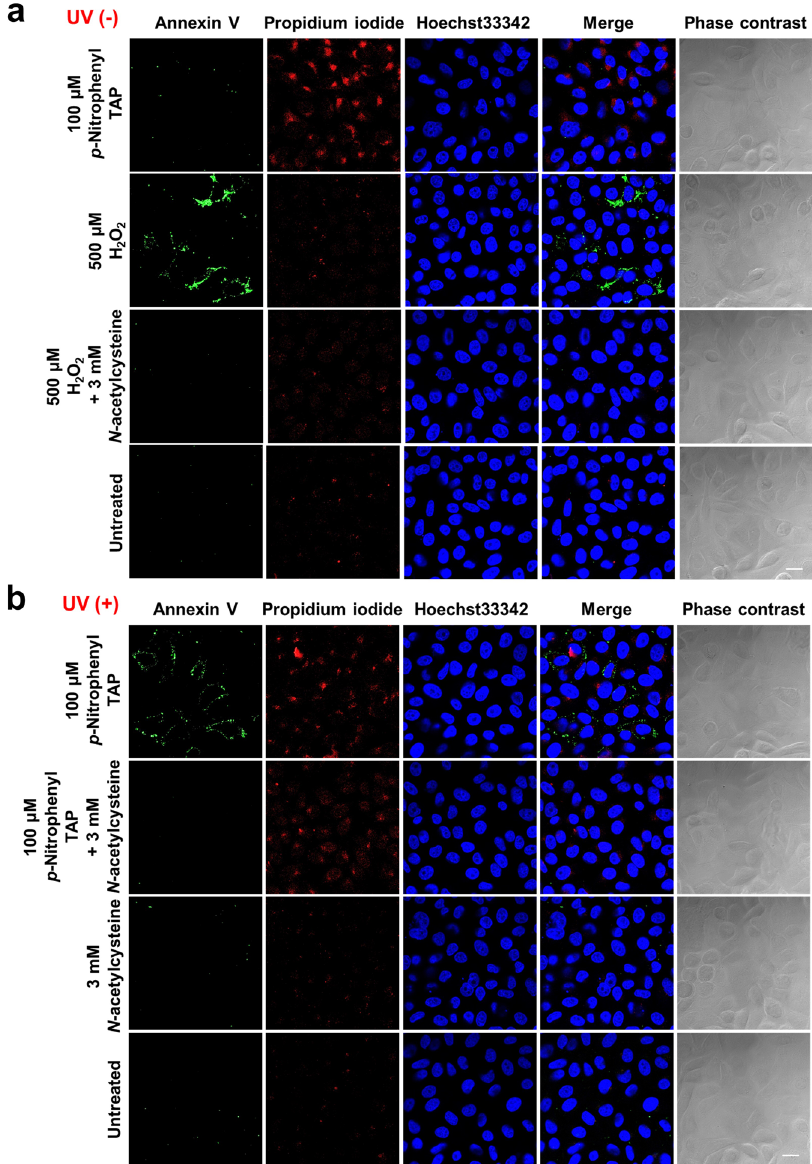
Fig. 7 Detection of apoptosis in 1d after UV irradiation. a HeLa cells were cultured with 100 µ M of 1d or 500 µ M H 2 O 2 for 1 h with or without 3 mM NAC, and the cells were incubated with FITC-Annexin V (Green), propidium iodide (PI) (Red), and Hoechst33342 (Blue), and observed by confocal microscopy. b HeLa cells were cultured with 100 µ M of 1d or 500 µ M H 2 O 2 for 1 h with or without 3 mM NAC, and treated with UV irradiation. After irradiation, the cells were incubated with FITC-Annexin V (Green), propidium iodide (PI) (Red), and Hoechst33342 (Blue), and observed by confocal microscopy. Scale bar = 20 μ